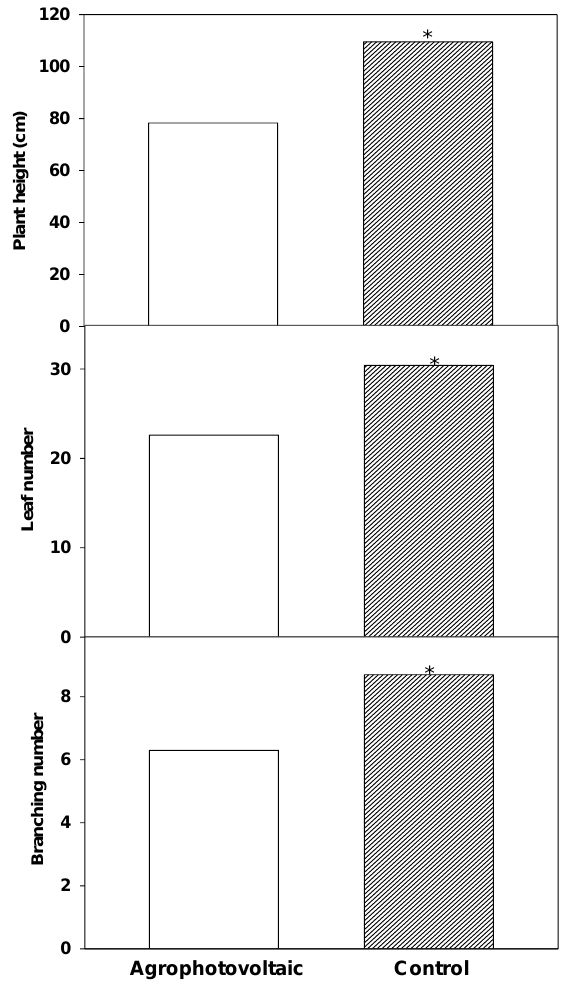
Figure 2. Growth of sesame underneath an agrophotovoltaic (APV) system in Goesan, South Korea. * significantly different between APV system and control plot using a t -test ( p = 0.05). Two APV facilities (Paju and Youngkwang) were used for the soybean study. The plant height and node number on the main stem underneath APV in Paju were signifi- cantly lower than the control plot 30 days after seeding (19 July 2021) (Figure 3). On the other hand, at 54 days after seeding (5 August 2021), the parameters were similar in the crops grown under APV systems and the control plots. The stem diameter underneath APV was significantly lower than the control plot at 54 days after seeding. In the Youngkwang APV system, the plant height and node number on the main stem were sim- ilar in crops grown under the APV systems and in control plots at 16 days after seeding (19 July 2021). In contrast, the node number on the main stem and stem diameter under- neath the APV were lower than the control plot at 33 days after seeding (5 August 2021). Most parameters, such as pod weight, pod number per plant, seed number per plant, grain weight per plant, 100 seed weight, plant number/m 2 , and liter weight at harvest, were similar in the crops grown under APV systems and in the control plots (Table 6). On the other hand, the ungrained ratio per pod underneath the APV was significantly higher than that in the control plot. Furthermore, the yield underneath the APV was reduced by 18% compared to the control plot. Similar to Paju, the ungrained ratio per pod underneath the APV in Youngkwang was significantly higher than the control plot. In addition, grain